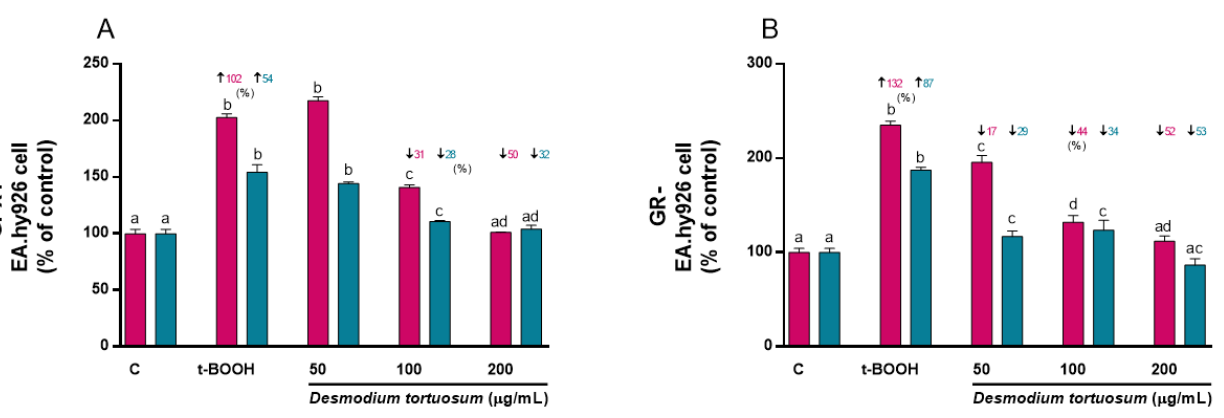
Figure 7. Direct effect of D. tortuosum extract on GPX and GR activities in EA.hy926 ( A , B ) and SH-SY5Y ( C , D ) cells after a 22 h of treatment period. GPX and GR activities were determined as % of control-change, and represent the mean ± SEM of four independent experiments. a,b,c Different letters show significance between groups at p < 0.05. ↓ represents percentage decrease with respect to control.